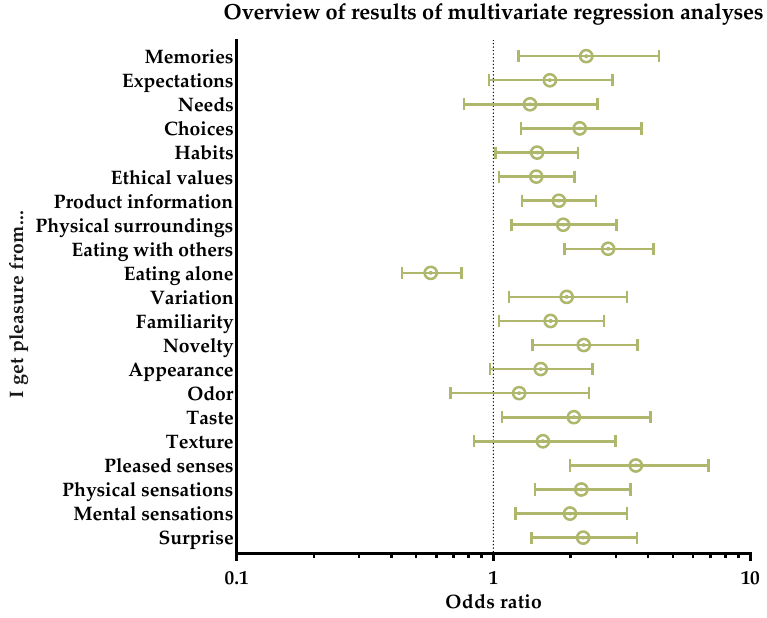
Figure 5. Low anhedonia group. Overview of results of multivariate regression analyses for the subjective perceptions of the 21 different pleasure aspects of the Food Pleasure Scale. Results are shown as odds ratios, including interquartile ranges. An odds ratio > 1 indicates an increasedlikelihood of choice, whereas odds ratio < 1 indicates a decreased likelihood of choice.